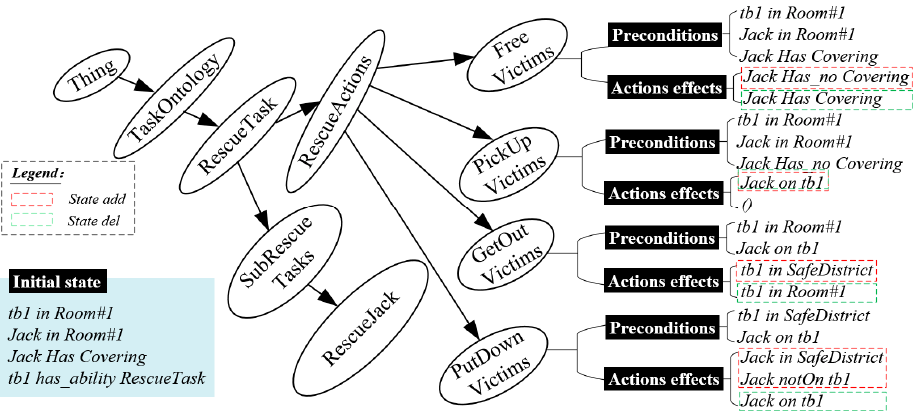
Figure 8. The representation method of atomic actions.